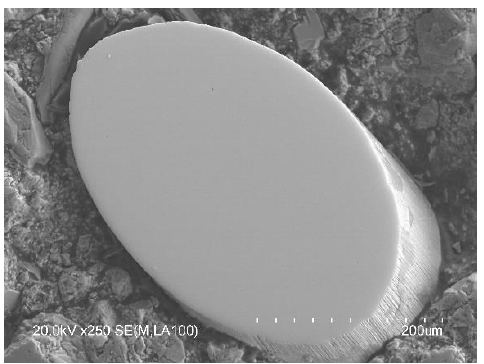
Figure 15. Detail of the surface of the recycled steel fiber embedded in the cementitious matrix.